Question: What does this figure show? Answer in one sentence.
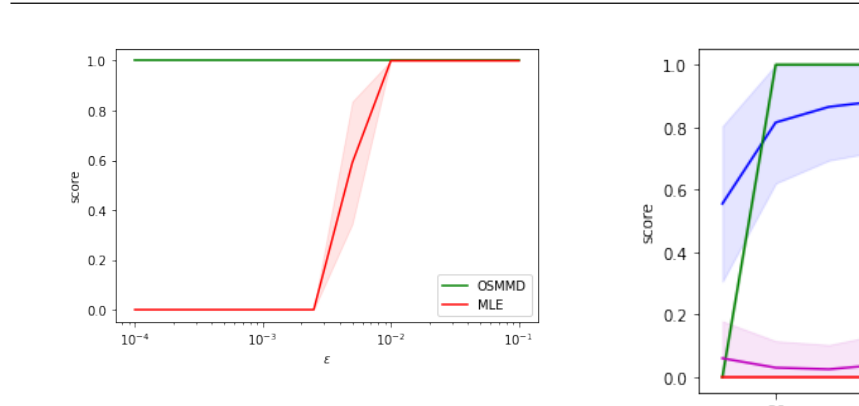
Answer: MLE vs MMD as a function of ε for covari- ance estimation. See Equation (6).